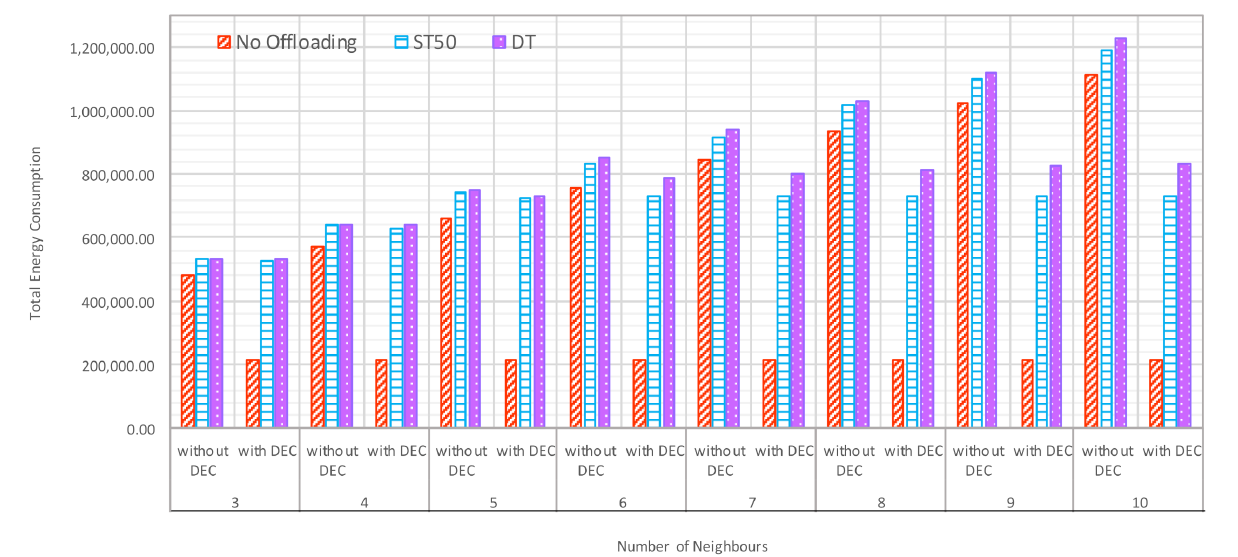
Figure 9. Impact of Increasing Number of Neighbors on Energy Consumption with Various Offloading